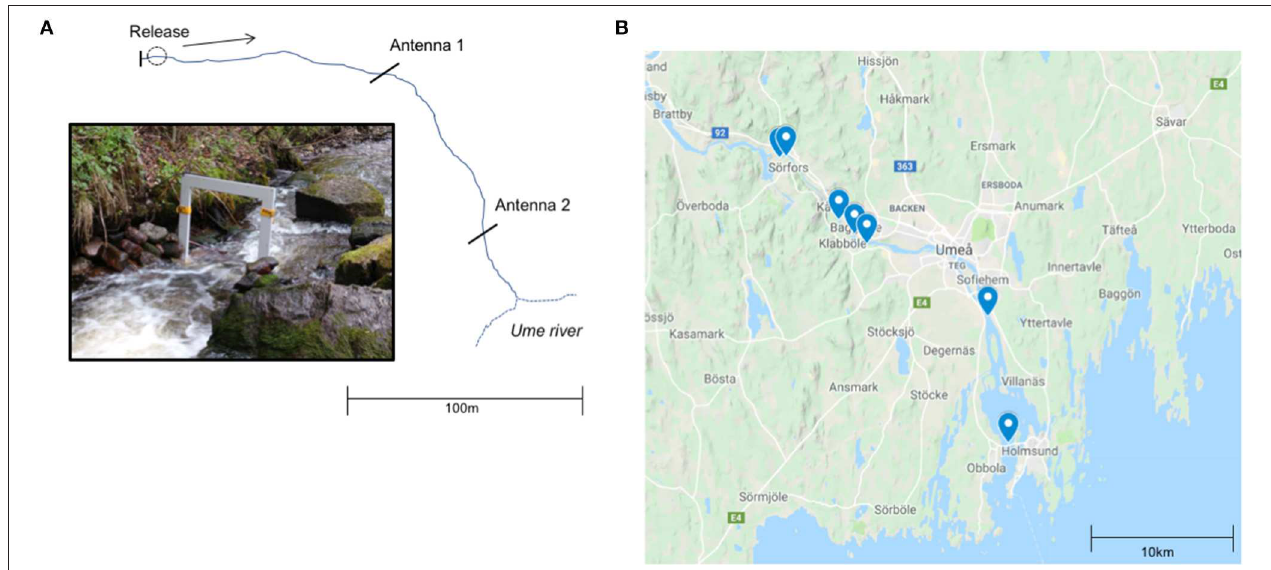
FIGURE 2 | (A) Illustration of creek antenna set-up for the small-scale migration study (Part 2) adapted from McCallum et al. (2019). Individuals were released at the origin of the creek and their downstream migration out to Ume River were tracked by two PIT-tag antennas. (B) Map of acoustic receiver locations in the Ume River used in large-scale field migration study. The creek is located directly upstream of the first receiver, as the creek joins the river at this location 63.88N, 20.026E (Part 3) map created with Google Maps.